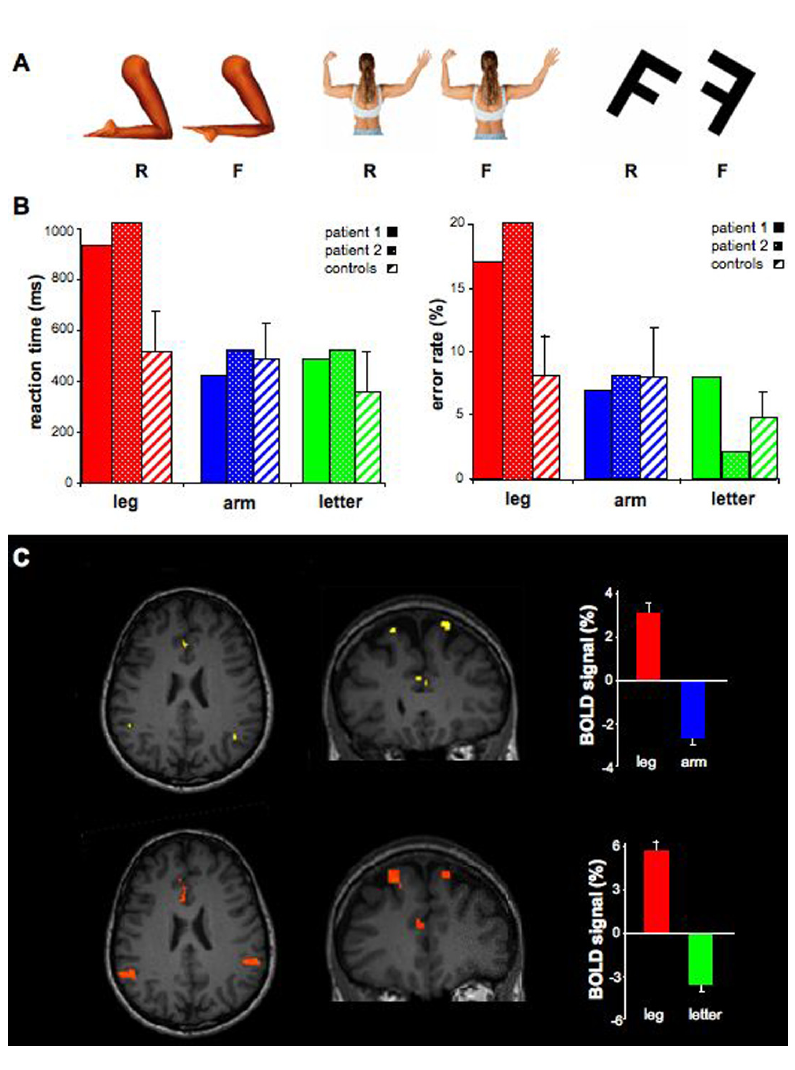
Figure 2. Mental rotation of legs, arms and letters. ( A ) Illustration of the stimuli used for tasks, including legs, arms and objects (letters), presented in right, normal view (R) or in false, inverse view (F). The stimuli were presented in five different angles (0°, 45°, 90°, 135°, 180°). Patients and control subjects were requested to determine as quickly as possible whether the stimulus was the normal one or the inversed one. ( B ) Mean reaction-times ( left ) and error-rates ( right ) for legs (red), arms (blue) and letters (green) are plotted separately for patient 1 (plain bars), patient 2 (points) and control subjects (strips). Note the significantly higher reaction times for the legs in the patients with respect to control subjects. Error bars represent the standard deviation. ( C ) BOLD responses in the anterior cingulate and left parietal cortex during mental rotation of legs with respect to arms ( upper row ) and letters ( lower row ). Percent signal changes are shown on the right (red: leg; blue: arm; green: